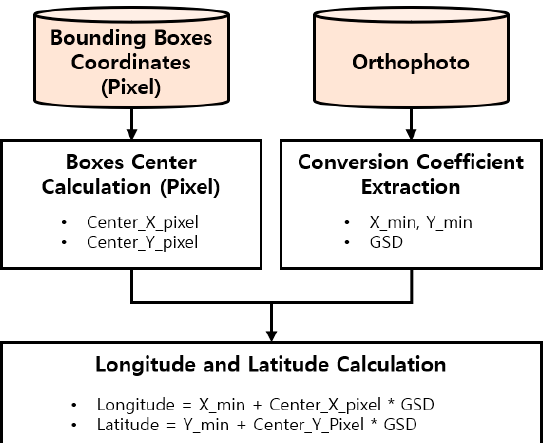
Figure 2. Conversion process of pixel coordinates to longitude-latitude coordinates.